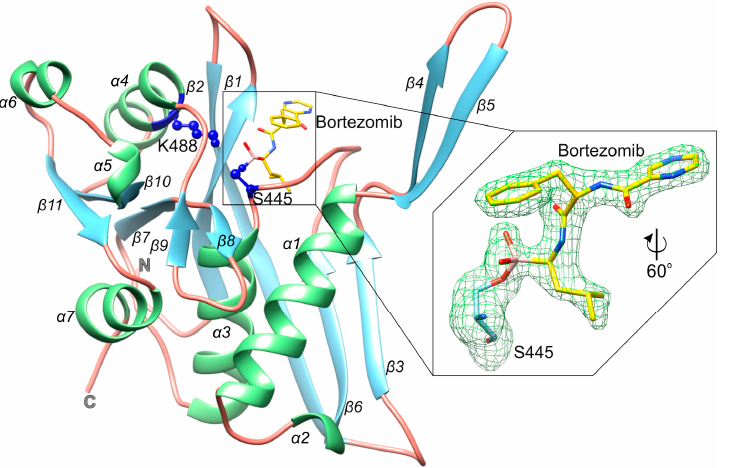
Figure 3. Structural details of the protease domain of Bs LonBA. Cartoon representation of the protease domain of Bs LonBA inhibited by bortezomib. Structure is color-coded by the secondary structure elements: helices (green), β -strands (light blue), coil regions (salmon); the catalytic dyad residues (S445 and K488) are marked with blue; right panel shows bortezomib bound to the catalytic S445 with displayed F o - F c omit map contoured at 3 σ level (green mesh). The unique β 4– β 5 inserted hairpin in Bs LonBA (392–405) is created by two five-resi- loop. Six inserts arranged around the three-fold symmetry axis complete a 12-stranded antiparallel β -barrel, where each insert forms nine hydrogen bonds with the neighboring from each protomer form a planar arrangement with their side chains in an extended con- formation and oriented towards the center of the barrel (Figure 4, top and middle ovals shaded gray). The top layer is formed by the side chains of Gln398. The width of the barrel